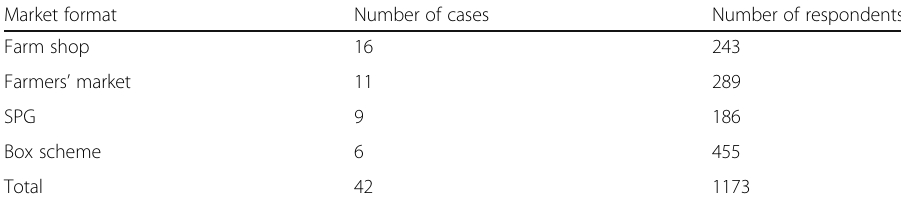
Table 1 AFN models covered by the survey and number of respondents Market